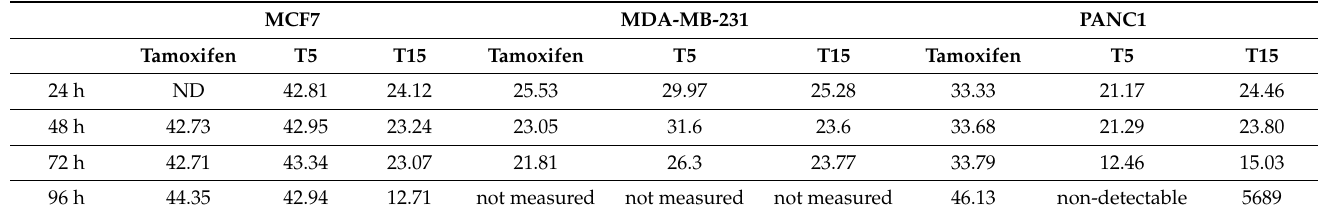
Table 2. IC 50 values of tamoxifen, T5 and T15 on MCF7, MDA-MB-231, and PANC1 (C) cells. Each cell line was treated with concentrations between 250 nM and 25 µ M. With each concentration, three parallel samples of the same cells were measured ( n = 3). ND =